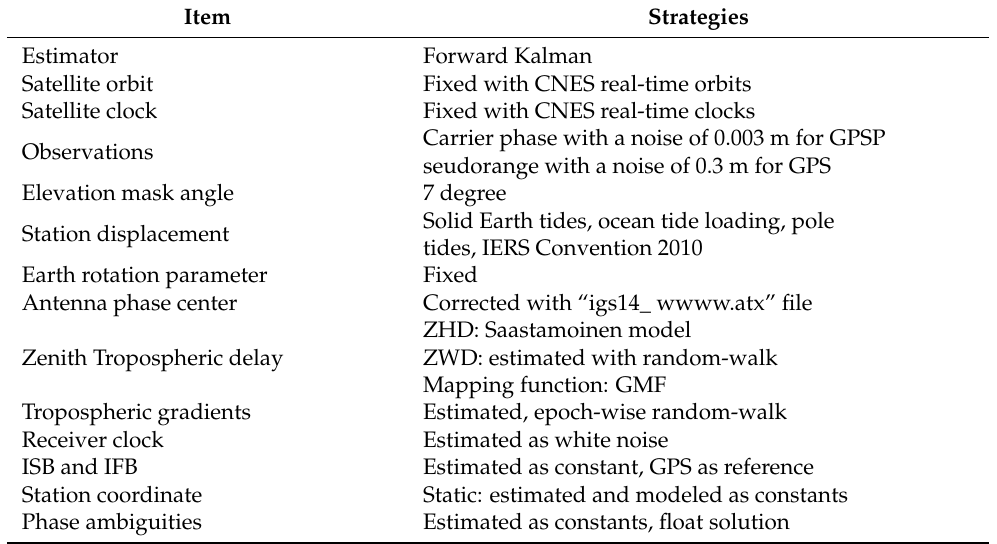
Figure 1. Distribution of the MGEX stations. Table 1. Processing strategies for the multi-GNSS troposphere estimation.